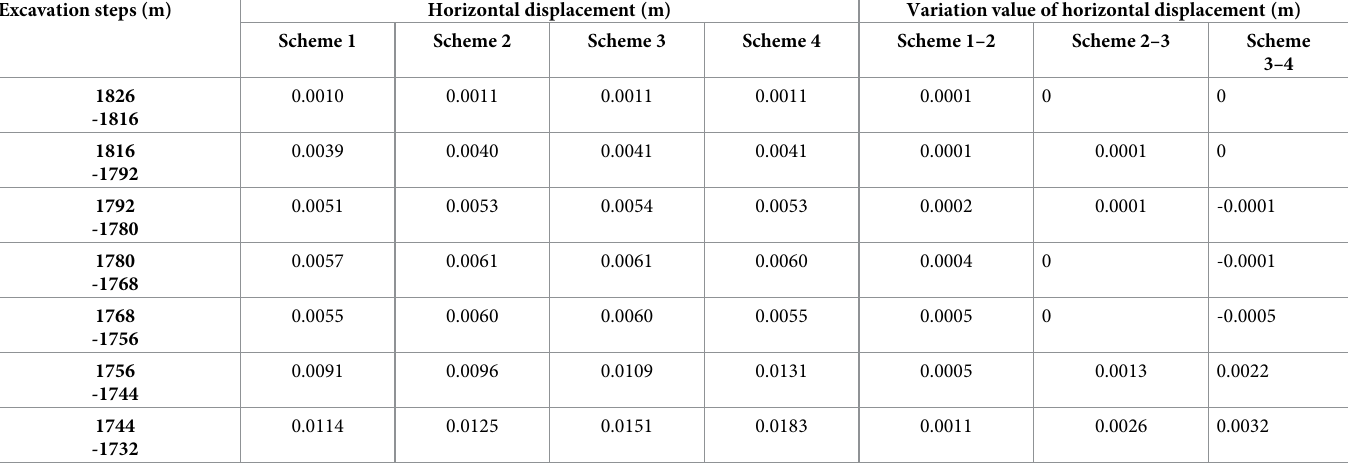
Analysis of optimum excavation slope angle of deep concave mine slope The analysis of the experimental scheme shows that the stability coefficient decreases with the increase in excavation depth and slope angle. The stability coefficient of scheme 1 and 2 is rela- tively high, but considering the control of maximum mining amount and the calculation results of Midas-GTS software are biased towards safety, scheme 2 is relatively better. The sta- bility coefficient of scheme 3 and 4 fluctuates around 1.3, and the stability coefficient of scheme 4 is significantly lower than 1.3. Therefore, scheme 3 is relatively better. Therefore, the opti- mum excavation slope angle is between scheme 2 and scheme 3. Table 5. Calculation of horizontal displacement of 1756-1744m stair under different excavation conditions. Excavation steps